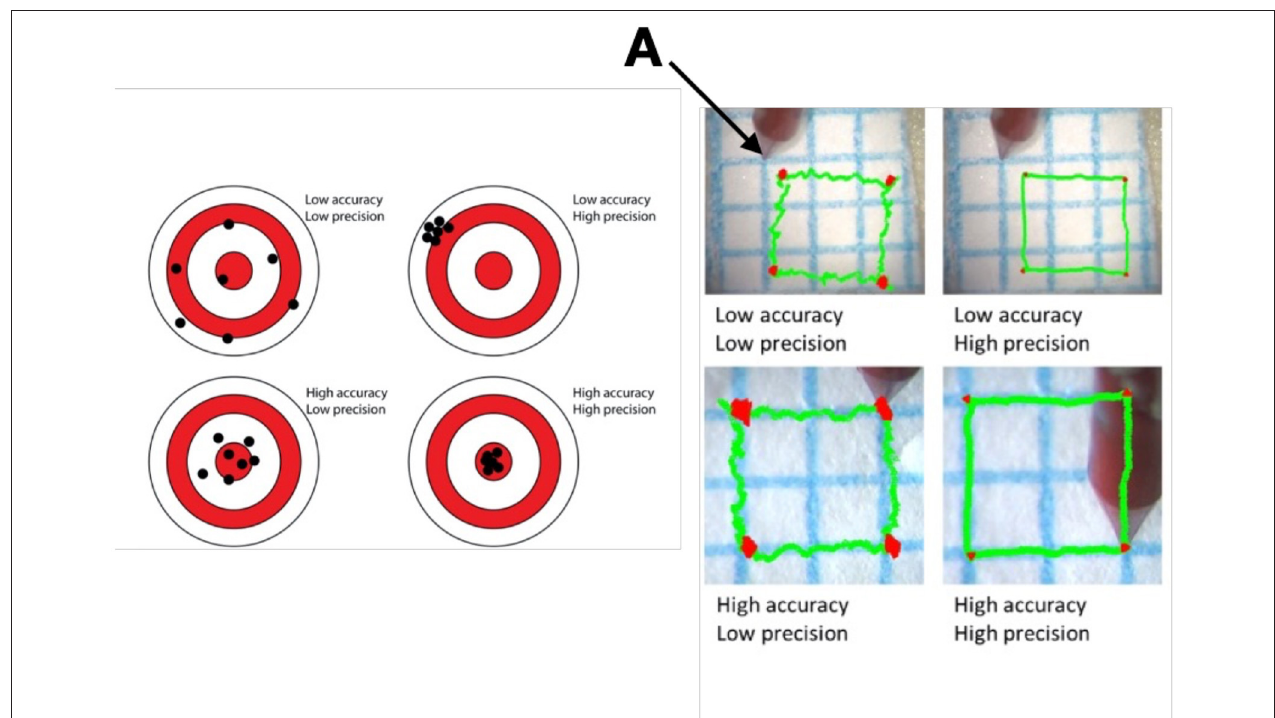
FIGURE 3 | Difference in Precision and Accuracy in a schematic on the right and a dynamic task on the left. Picture and schematic representations of experiments using a laser vibrometer and video recording to assess the ability of a surgeon to superimpose or maintain the blue line with the tip of an instrument (A) held in hand. Precision refers to the degree of reproducibility of the motion, while accuracy refers to the contiguousness achieved in reference to an intended